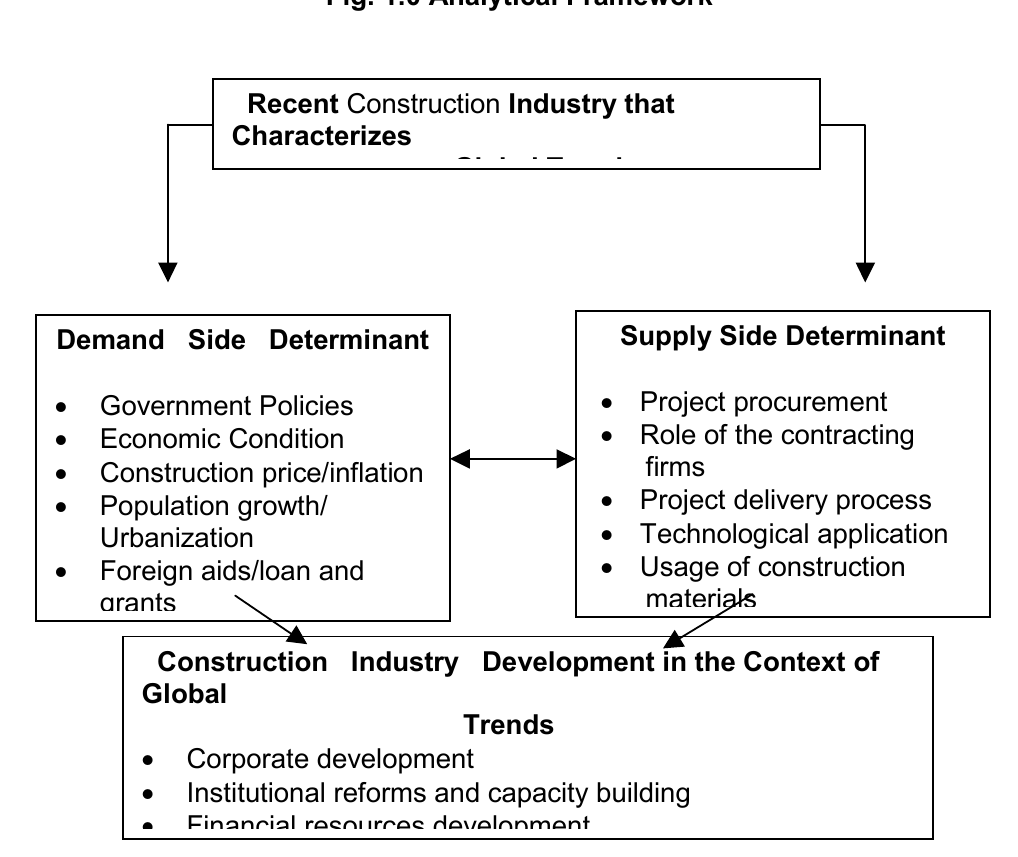
Fig. 1.0 Analytical